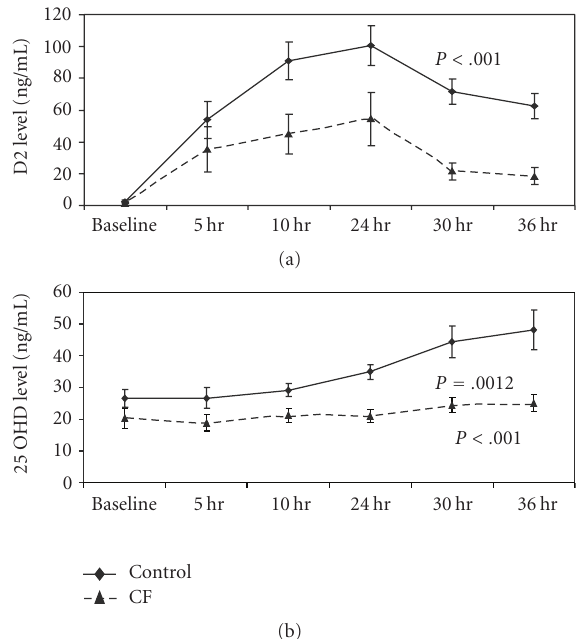
Figure 2: Impaired absorption of Vitamin D following a 2500 ug dose in in CF patients and controls